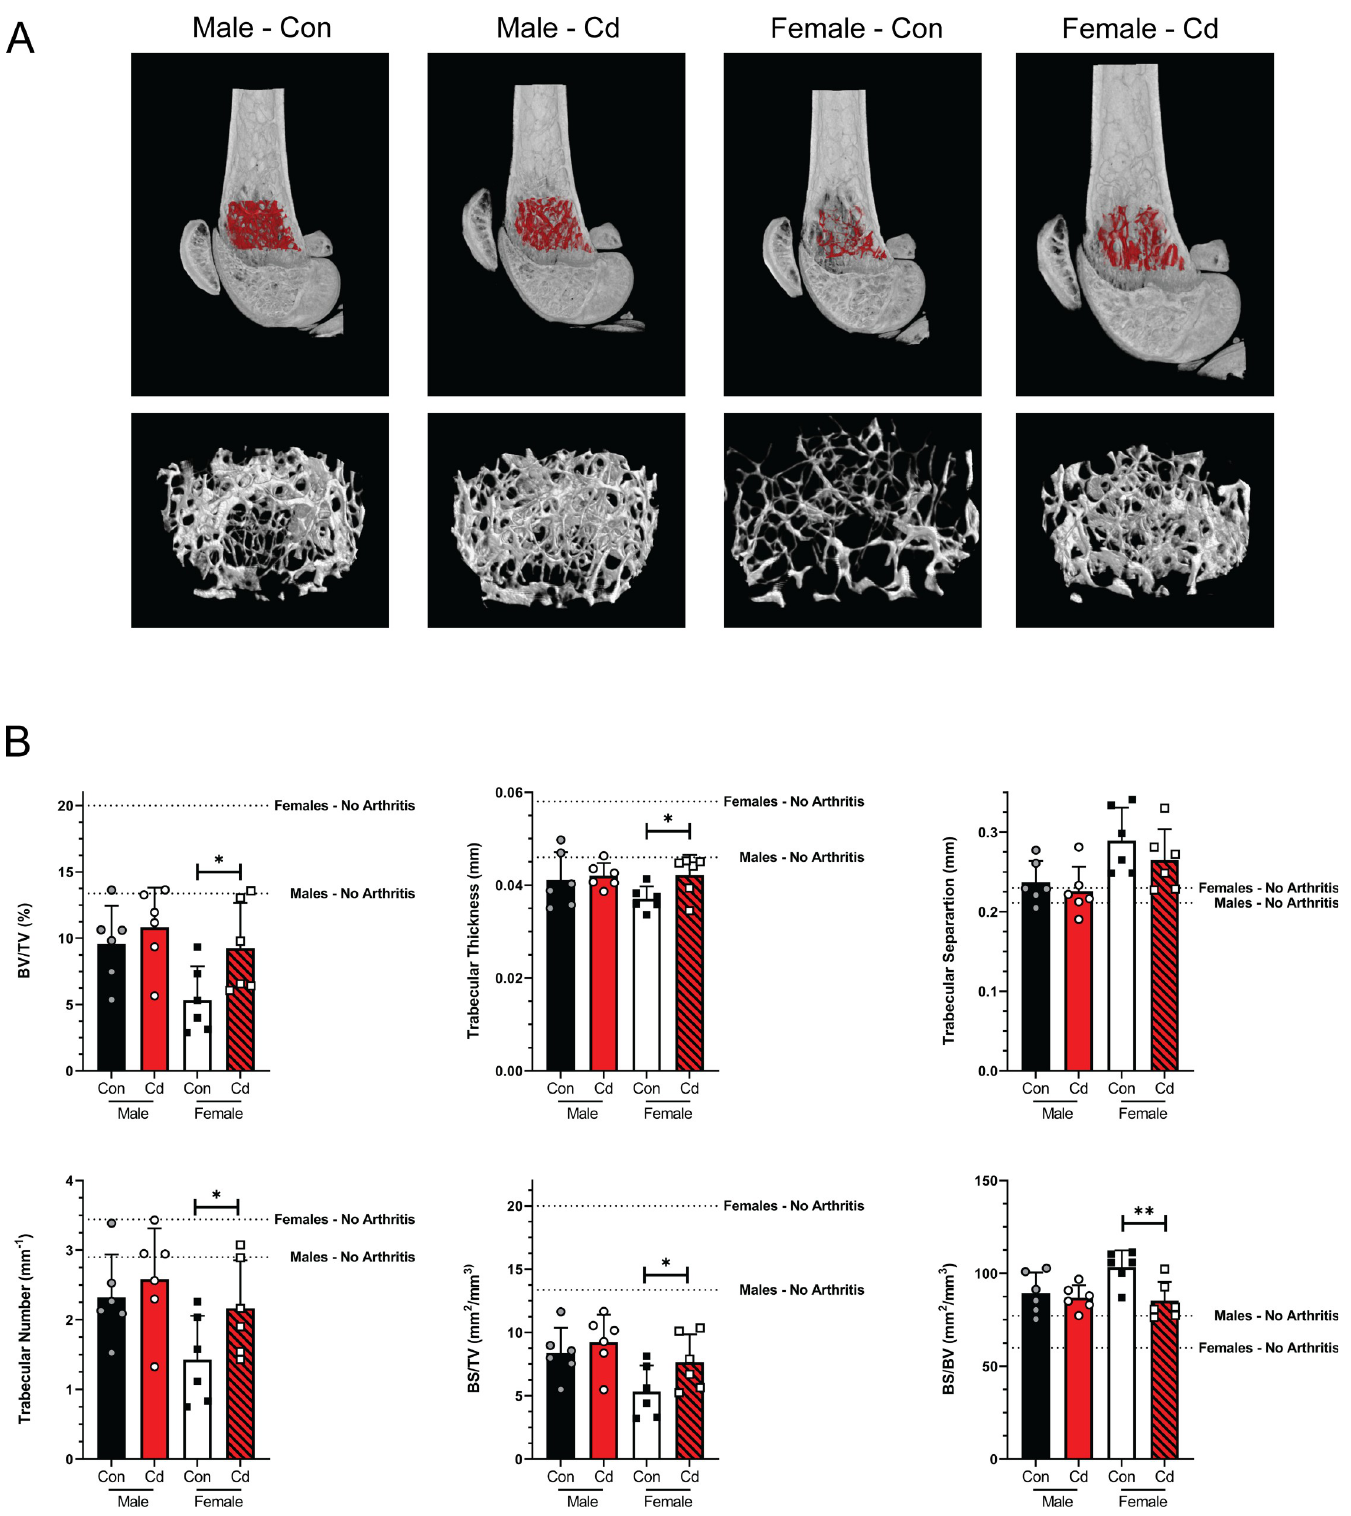
Fig 7. MicroCT analysis of the femurs of arthritic Control and Cd-exposed SKG offspring. Femurs of control and Cd-exposed offspring were analyzed by μ CT. (A) Cross sections of μ CT images of mice representing median mice presented in B. The VOI is highlighted red and shown enlarged below. (B) Quantification of trabecular bone architecture. BV/TV–bone volume/total volume of interest, BS/TV–bone surface/total volume of interest, BS/BS–bone surface/bone volume. Data are presented as mean ± SD. N = 4 per group. https://doi.org/10.1371/journal.pone.0249442.g007 PLOS ONE | https://doi.org/10.1371/journal.pone.0249442 September 3,